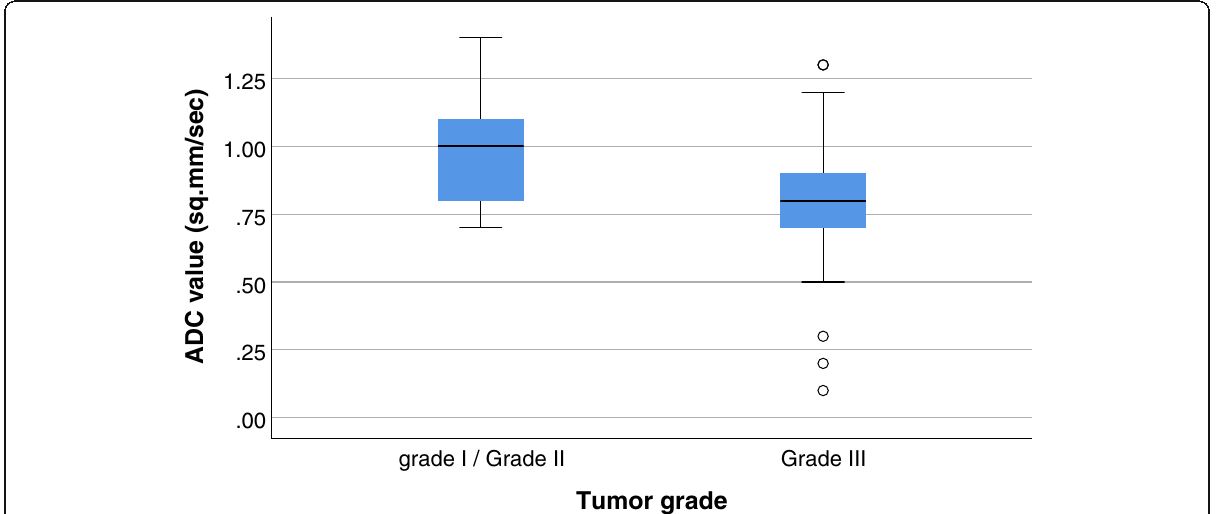
Fig. 10 A box plot that shows median and interquartile range (IQR) of ADC values of GIII lesions and those of grades I/II